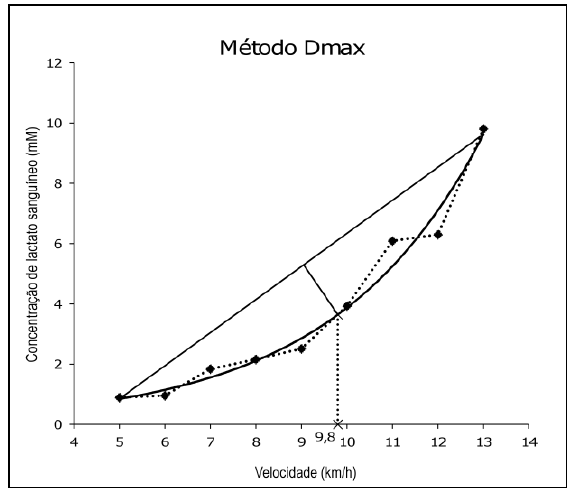
1. Velocidade no limiar de lactato determinada pelo método Dmax (dados fictícios). Neste exemplo a vLL é 9,8 Dmax